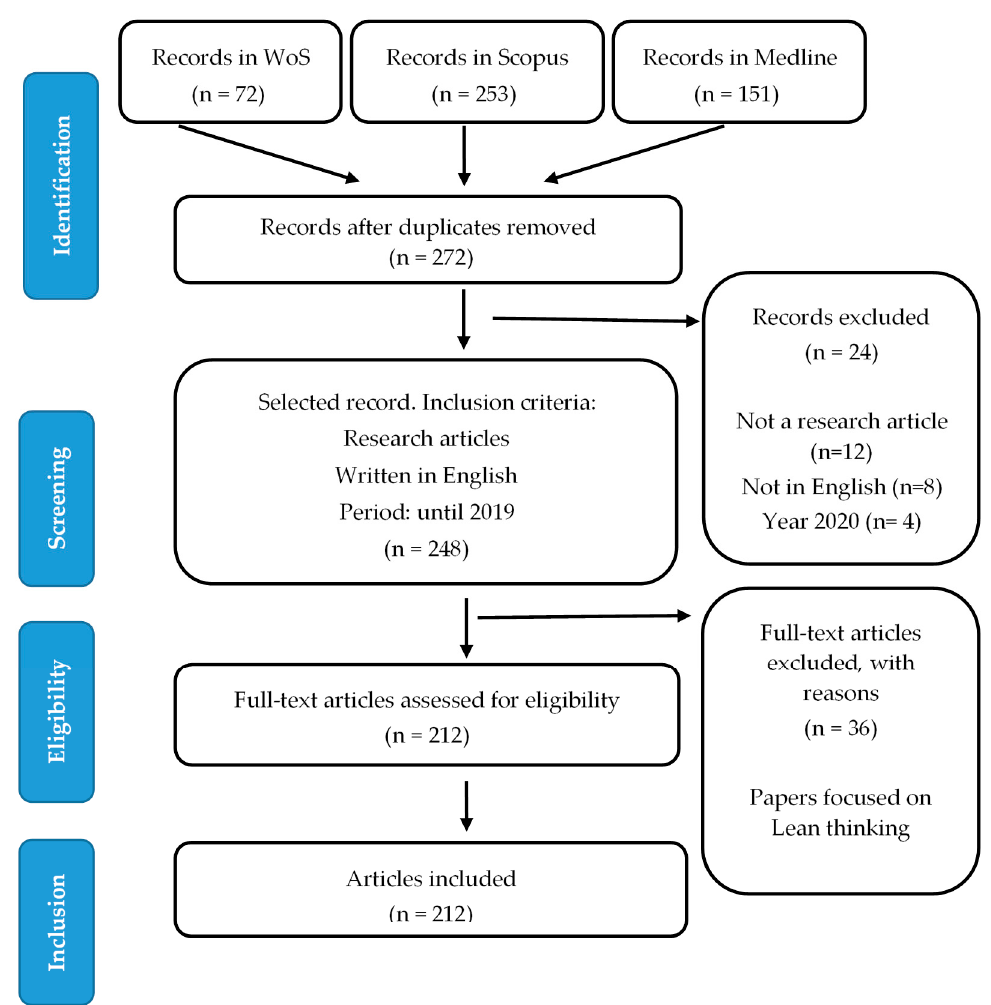
Figure 1. PRISMA. Figure 1.